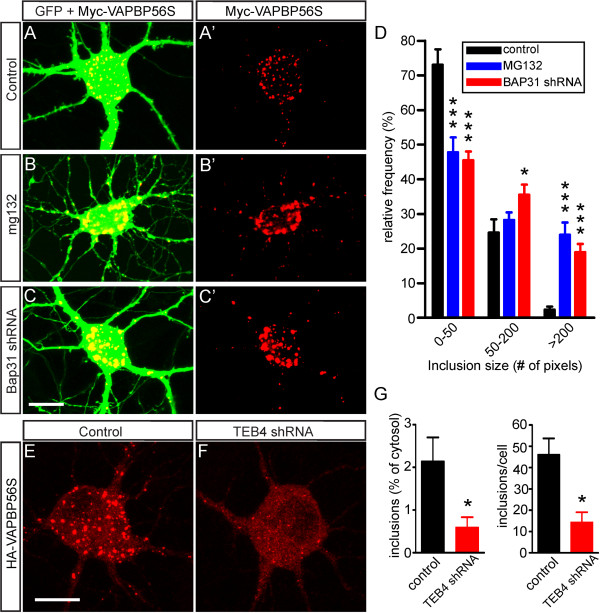
Altering ERAD influences the size of mutant VAPB inclusions. A-D) Incubation of GFP and Myc-VAPB-P56S transfected primary cultured hippocampal neurons with MG132 to inhibit proteasome (B), or BAP31 shRNA construct to down regulate BAP31 expression (C) result in increased size of mutant VAPB inclusions as compared to untreated cultures (A). The relative frequencies of small (< 50 pixels) and large (>200 pixels) were reduced and increased, respectively, by MG132 and BAP31 shRNA treatment (D). * and ***, P < 0.05 and <0.0001 compared to control; one-way ANOVA, Tukey’s post-test. E-G) TEB4 shRNA reduces size and number of mutant VAPB inclusions in cultured hippocampal neurons, also resulting in a reduction of the proportion of cytosol occupied by inclusions in TEB4-shRNA treated cells (G). *, P < 0.05 compared to control (Student’s t-test). Scale bar, 10 μm.